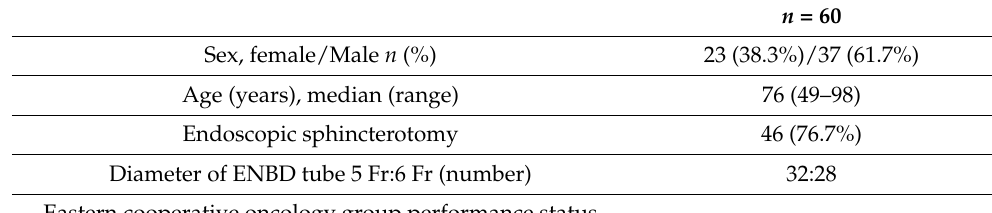
Table 1. Patients’ baseline